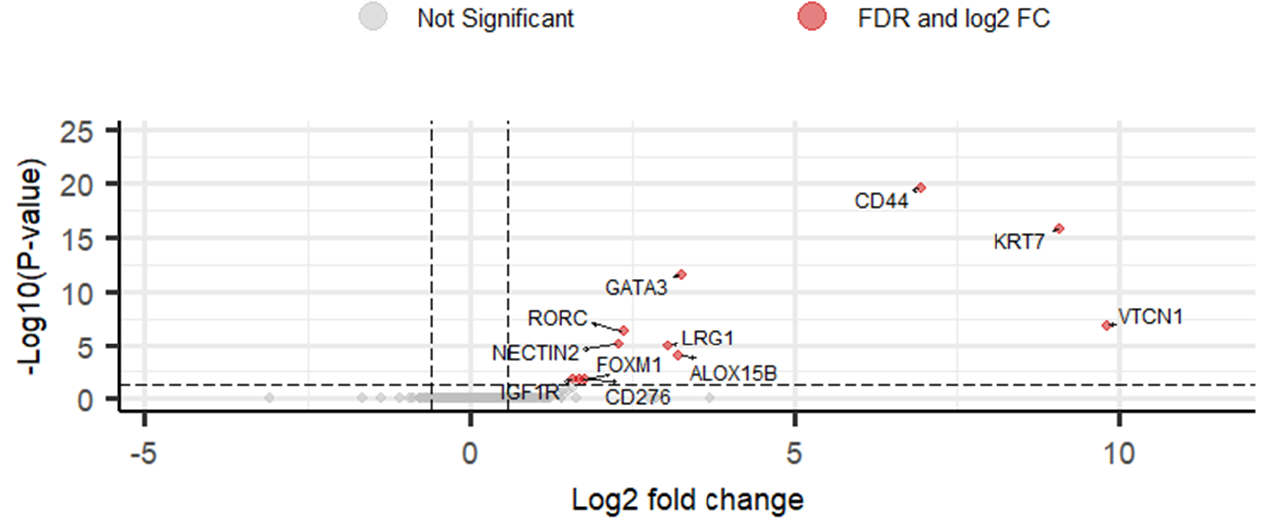
Figure 2. Volcano plot of DESeq2 results for comparison of gene expression levels between pN1 and pN0 using as threshold log2 fold change greater than |0.58| and FDR < 0.05. Eleven differentially expressed genes (DEGs) were identified (red points). Grey points correspond to all other genes. Vertical lines represent the negative and positive values of log2 fold change cut-off. The horizontal line represents the FDR cut-off.